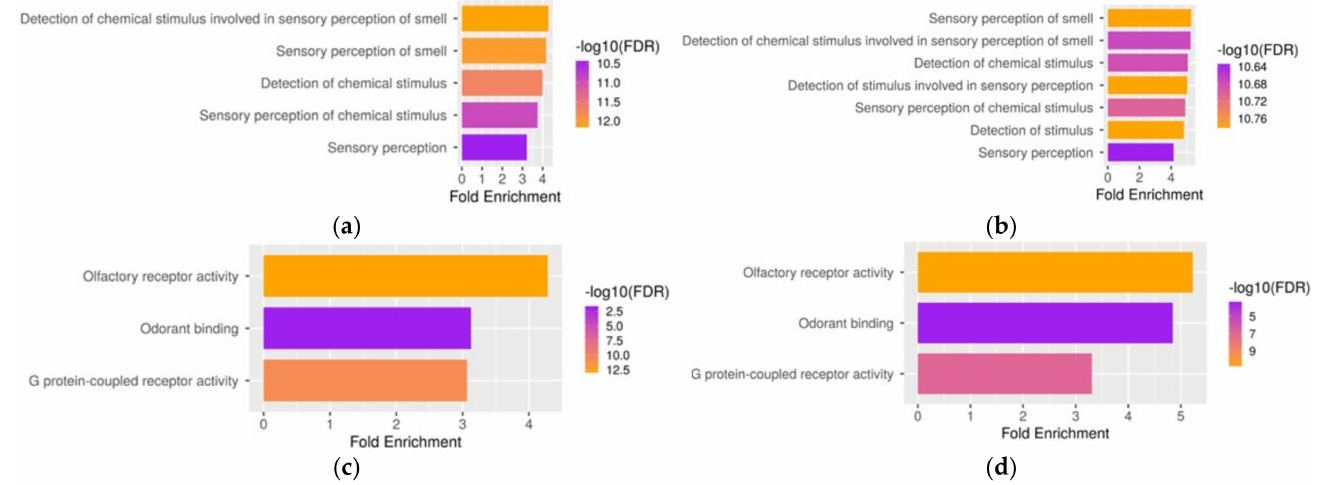
Figure 4. GO terms enriched by genes co-expressed with TAAR6 in the nucleus accumbens medium spiny neurons (GSE121199). ( a ) Biological-process GO terms enriched in top-500 TAAR6 co-expressed genes in the D1-medium spiny neurons; ( b ) biological-process GO terms enriched in top-500 TAAR6 co-expressed genes in the D2-medium spiny neurons; ( c ) molecular-function GO terms enriched in top-500 TAAR6 co-expressed genes in the D1-medium spiny neurons; ( d ) molecular-function GO terms enriched in top-500 TAAR6 co-expressed genes in the D2-medium spiny neurons. Bar colors indicate the false-discovery-rate (FDR) value. There was no significant GO term enrichment for TAAR6 co-expressed genes in cholinergic interneurons